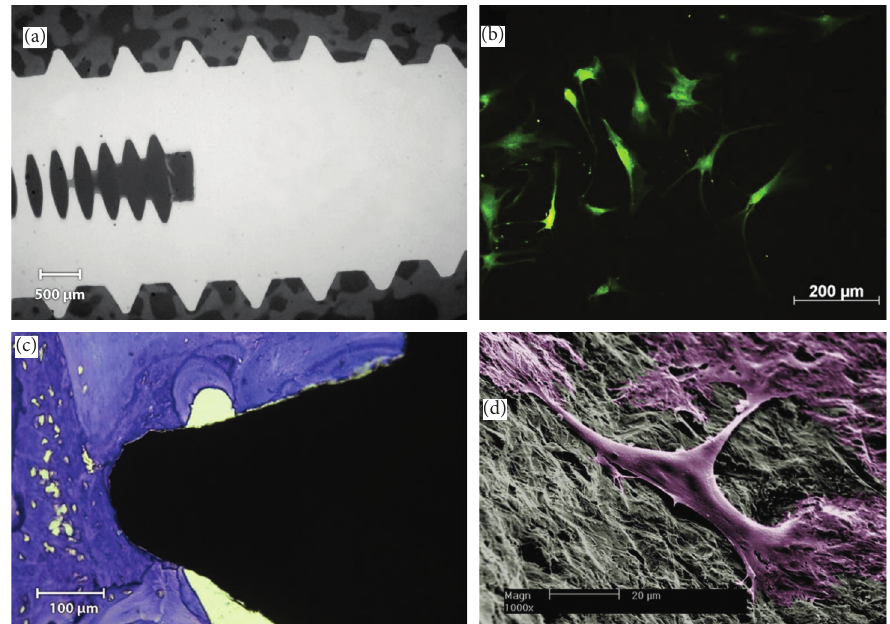
Figure 4: Osteocyte interaction with titanium. (a) Microradiograph with no connective tissue sheath on the implant threads after 12 weeks (magnification 20x). (b) Fluorescence microscopy images of human osteoblast cells after incubation with the 10min eluates of a titanium implant after staining with fluorescein diacetate and propidium iodide. The presence of green (fluorescein diacetate) without red (propidium iodide) indicates living cells without dead cells. (c) After 12 weeks of healing, mature lamellar bone is evident in intimate contact with the titanium implant (toluidine blue, magnification 50x). (d) Close-up SEM images of a titanium implant seeded with human osteoblast cells. Good contact of the cells to the implant surface is shown (magnification 1000x) (reproduced from multiple figures with permission from M¨oller B, Terheyden H, Açil Y, Purcz N. M, Hertrampf K, Tabakov A, Behrens E, Wiltfang J, A comparison of biocompatibility and osseointegration of ceramic and titanium implants: an in vivo and in vitro study . Int J Oral Maxillofac Surg . 2012 May; 41(5):638–645. doi: 10.1016/j.ijom.2012.02.004. Epub 2012 Mar 8. PMID: